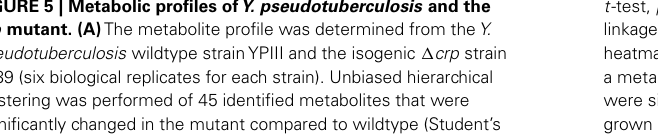
t -test, p -value < 0.05). Clustering was performed using average linkage and Euclidean distance.The analysis is visualized by a heatmap in which each square represents the normalized intensity of a metabolite. (B) Box-and-whisker plots illustrating metabolites that were significantly changed between the crp mutant and the wildtype grown in LB at